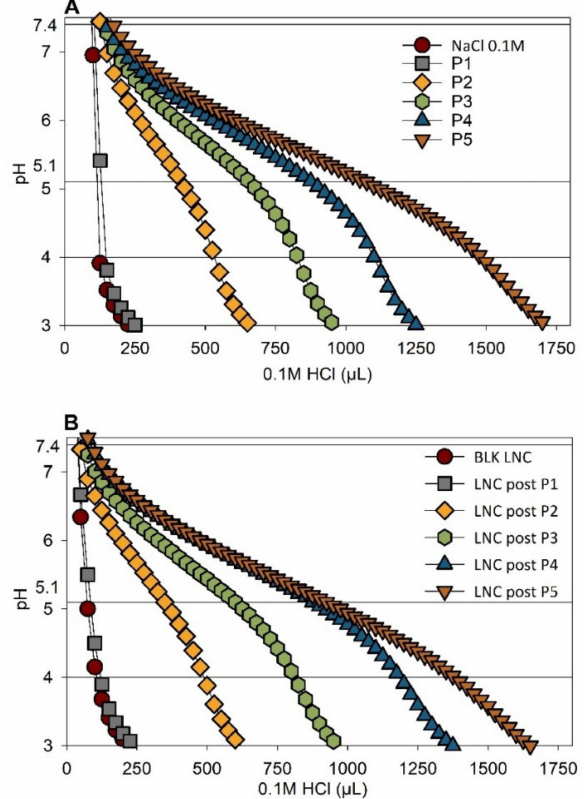
Figure 3. Endosome buffering effect. Acid–base titration of ( A ) polymer solution at a concentration of 0.1 mM and ( B ) LNC post inserted. Blank LNC (“BLK LNC”) and modified LNC with polymer C 18 H 37 -PNVP 49 (“P1”), C 18 H 37 -P(NVP 15 -co-Vim 5 ) (“P2”), C 18 H 37 -P(NVP 22 -co-Vim 8 ) (“P3”), C 18 H 37 -